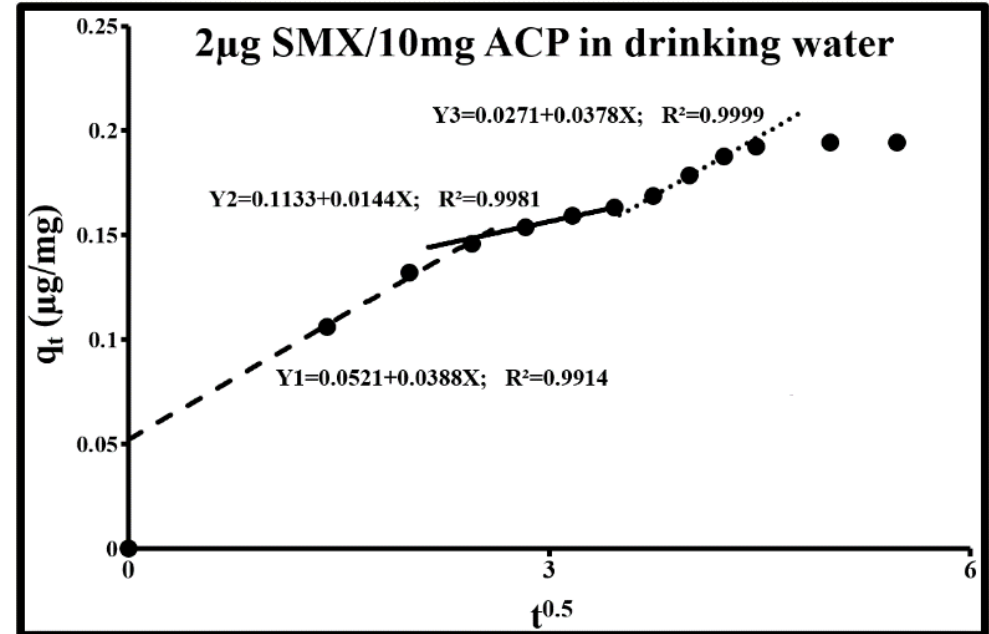
Figure 5. Weber–Morris plots for the sorption of SMX by ACP Norit SA Super in drinking water. (SMX: 2µg/L; ACP: 10 mg/L; pH = 8.1, T = 293 K).